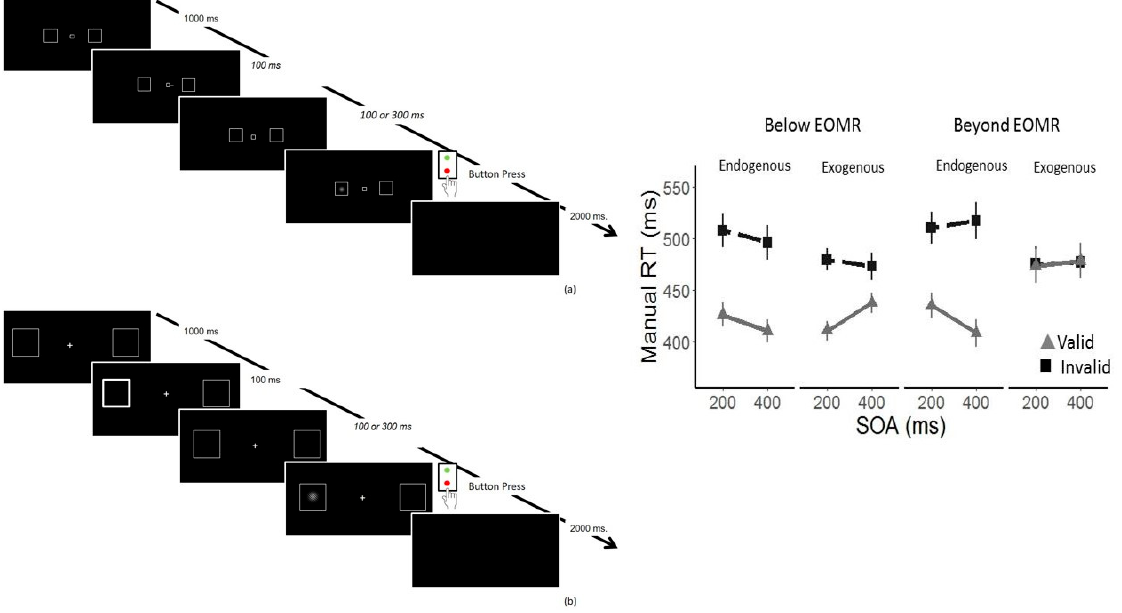
Figure 3. The sequence of events in the endogenous cueing ( a ) and exogenous cueing ( b ) tasks. The right panel shows the mean manual reaction time (RT) in ms as a function of Stimulus Onset Asynchrony (SOA) and cue validity for below and beyond the EOMR separately for the endogenous and exogenous cueing task (Exp. 3). Adapted from [103].